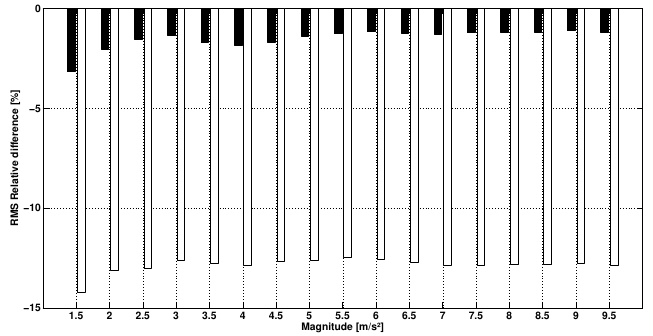
Figure 5. RMS relative difference between the IMUA and its reference vs. frequency ( Black : H 1344 –R 1344 , White : H 400 –R 400 ).